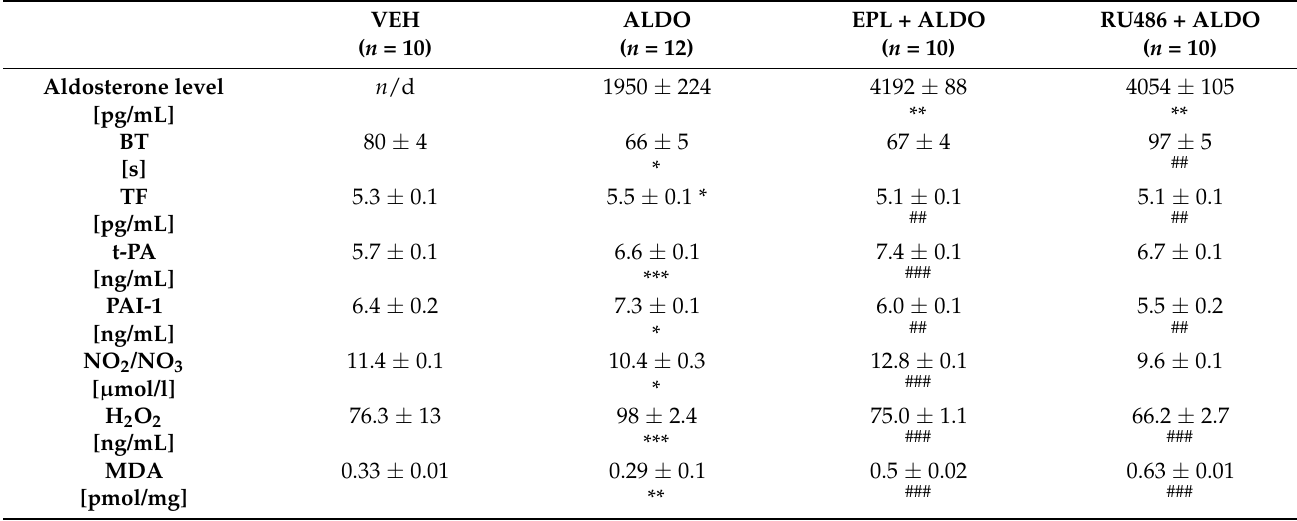
Table 2. The role of mineralocorticoid and glucocorticoid receptors in the impact of aldosterone on hemostasis, nitric oxide bioavailability, and oxidative stress in adrenalectomized diabetic rats.